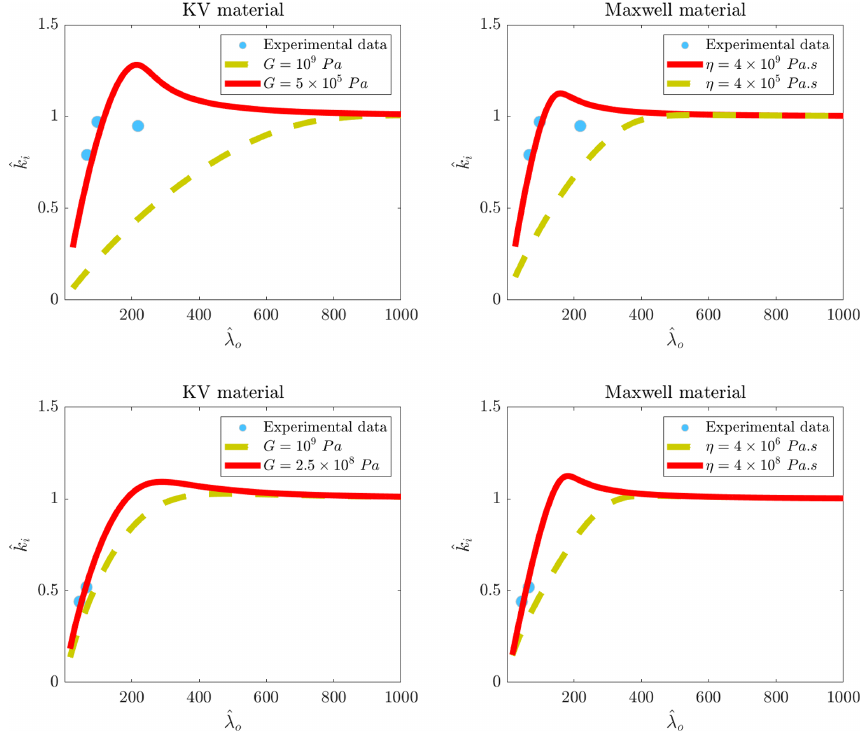
Figure 11. Comparison between ˆ k i vs. ˆ λ o curves predicted by wet beam models and the data measured by Yiew et al. (2019). Upper and lower rows show the data related to freshwater ice covers with thicknesses of 1 and 1.5cm